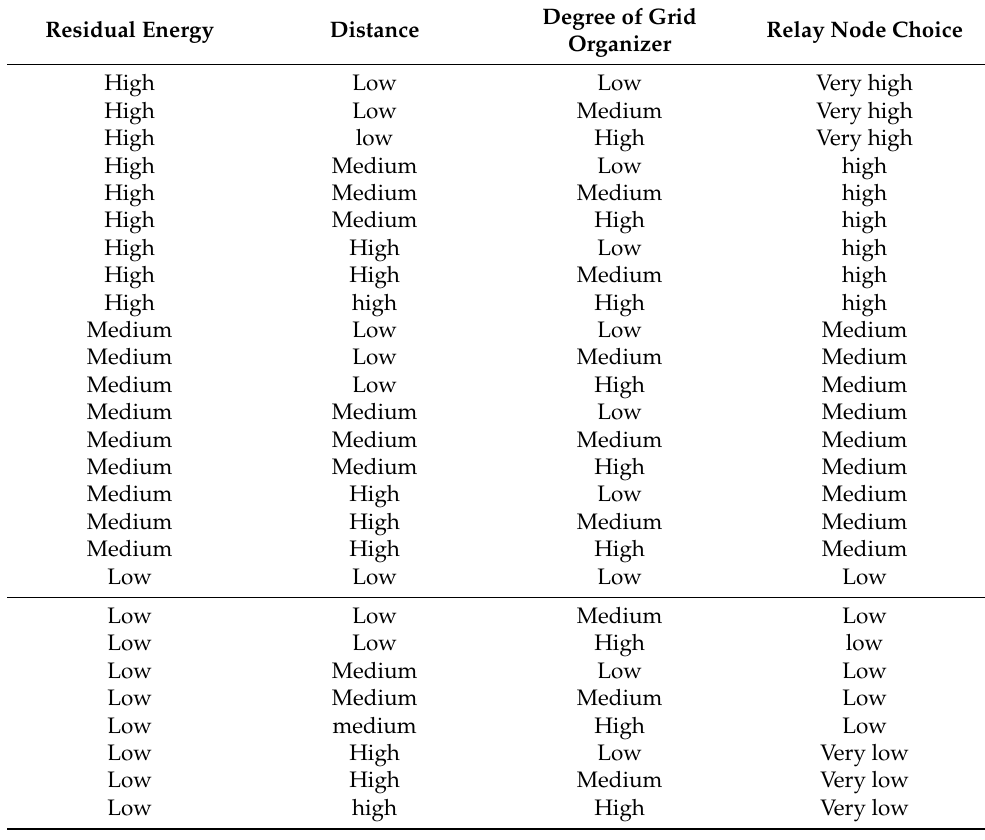
Table 2. Fuzzy rules for selection of grid organizer as relay node.